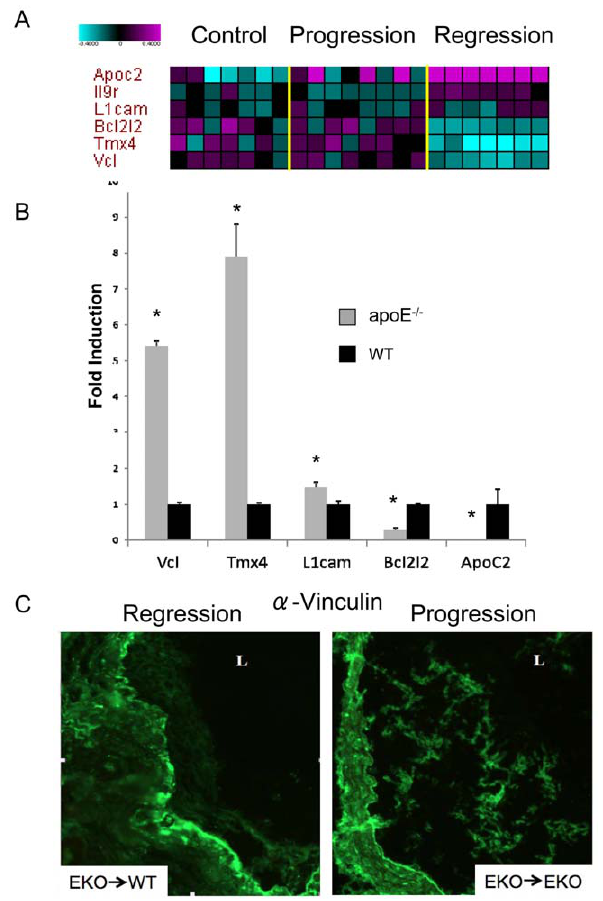
Figure 5. Multivariate causal pathway analysis for genes involved in regression. (A) Heatmap displaying the relative levels of the 6 genes selected by HITON-PC algorithm for causal relationship to regression vs. progression/baseline task (Y-axis) in each of the 22 analyzed aortic samples (X-axis). B) RNA was isolated from laser captured CD68 + cells. qPCR was then performed in order to validate microarray results. The symbol * corresponds to statistical significance, p , 0.05, when signal in RNA from aortas in regression (apoE 2 / 2 ) was compared to signal in RNA from aortas in progression (WT). 9 mice were analyzed per group. GAPDH was used for normalization. C) Immuno- staining for vinculin in a plaque derived from an aortic arch transplanted from an apoE 2 / 2 mouse into a wild type normolipidemic mouse (apoE 2 / 2 . WT) and from an apoE 2 / 2 mouse into a different apoE 2 / 2 mouse (apoE 2 / 2 . apoE 2 / 2